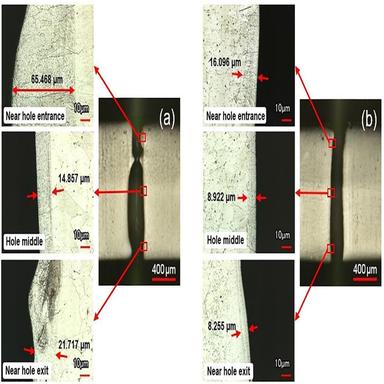
Etched through-hole section analysis for comparing recast layer characteristics formed under the water-based ultrasonic powers of (a) 0 W and (b) 467 W using a single laser pulse without assist gas blowing.